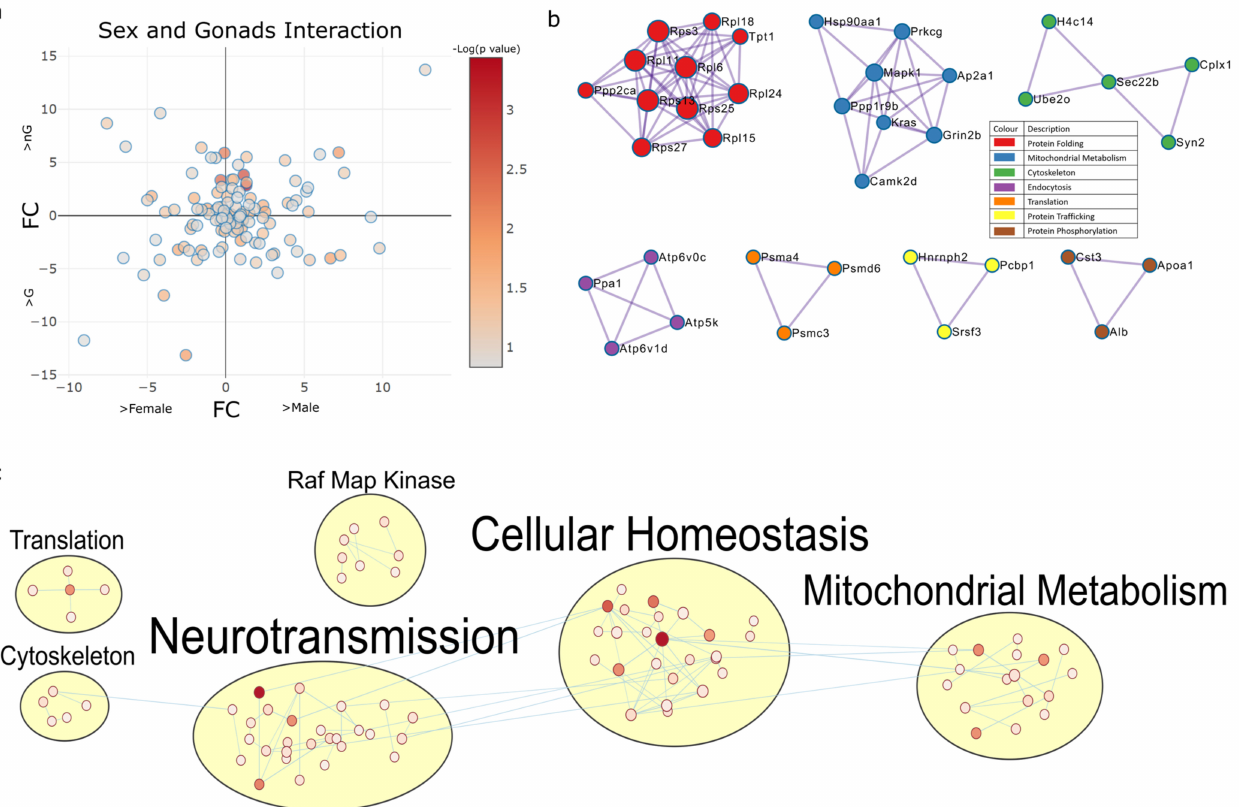
Figure 4. Two-way interaction of proteins regulated by sex–gonad interactions. ( a ) A total of 119 pro- teins were identified to be regulated by the interaction between sex and gonads. ( b ) PPI analysis of these proteins found Nonsense-Mediated Decay (NMD) enhanced by the Exon Junction Complex (EJC) (red, p = 1.56 × 10 − 22 ), respiratory electron transport (blue, 3.16 × 10 − 17 ), cytoplasmic riboso- mal proteins (green, p = 6.3 × 10 − 14 ), the proteosome (orange, p = 1 × 10 − 8 ), mRNA splicing (yellow, p = 6.3 × 10 − 7 ) and post-translational protein phosphorylation (brown, p = 1.58 × 10 − 7 ) to be the top enriched functions, per cluster. PPI analysis without MCODE-driven clustering revealed Nonsense-Mediated Decay to be the most enriched function ( p = 3.16 × 10 − 10 ) regulated by sex and gonads. ( c ) Functions enriched by sex–gonad interactions were also grouped by observing functions associated with RAF-MAP kinase. Of these enriched functions, the most significant GO cellular component was the cytoplasm ( q = 4.14 × 10 − 17 ), the most significant GO molecular function was identical protein binding ( q = 2.92 × 10 − 7 ), the most significant reactome pathway was metabolism ( q = 1.66 × 10 − 5 ), the most significant KEGG pathway was endocrine and other factor-regulated calcium reabsorption ( q = 2.63 × 10 − 5 ) and the most significant GO biological process was central nervous system development ( q = 1 × 10 − 4